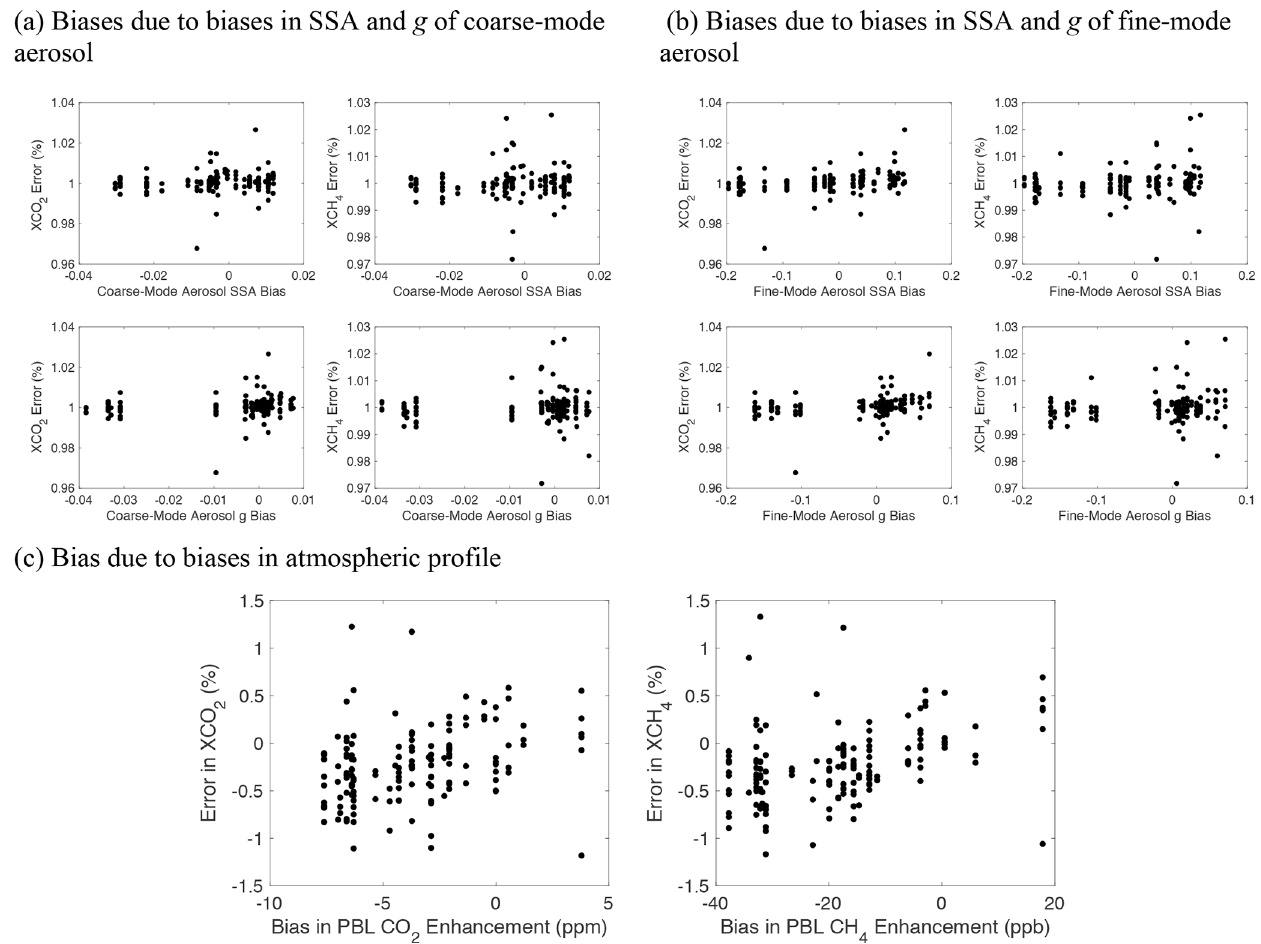
Figure 12. Results for Test 3 (a and b) and Test 4 (c) . Panels (a) and (b) show XCO 2 and XCH 4 biases as a function of biases in SSA and g (asymmetry factor) of coarse- and fine-mode aerosol, respectively. Panel (c) shows the same as a function of biases in PBL CO 2 and CH 4 enhancement. This bias is defined as the difference in PBL GHG mixing ratios between 3-hourly and monthly a priori atmospheric